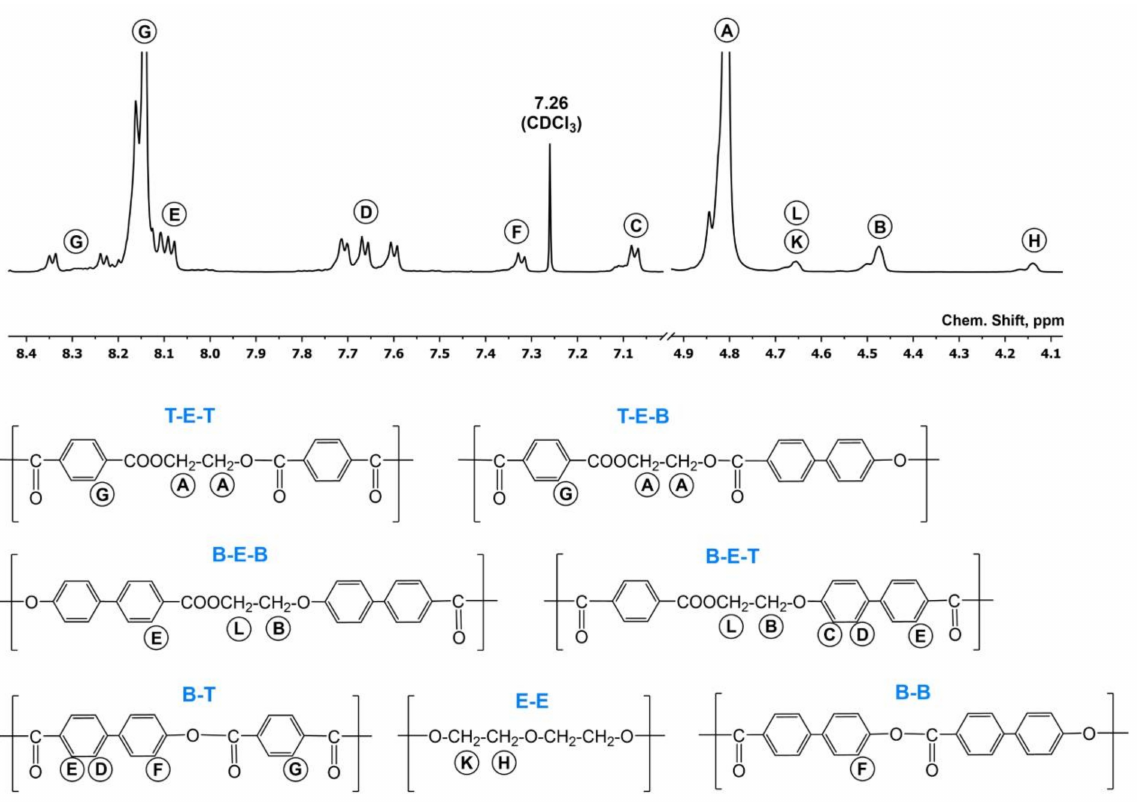
Figure 1. The 1 H NMR spectrum of copolyester C20 and possible structural units (dyads and triads) of C20–C80 copolyesters. The protons detected by 1 H NMR are marked by letters A–G. Table 2. Assignment of signals in the 1 H NMR spectra of different sequences of monomeric units